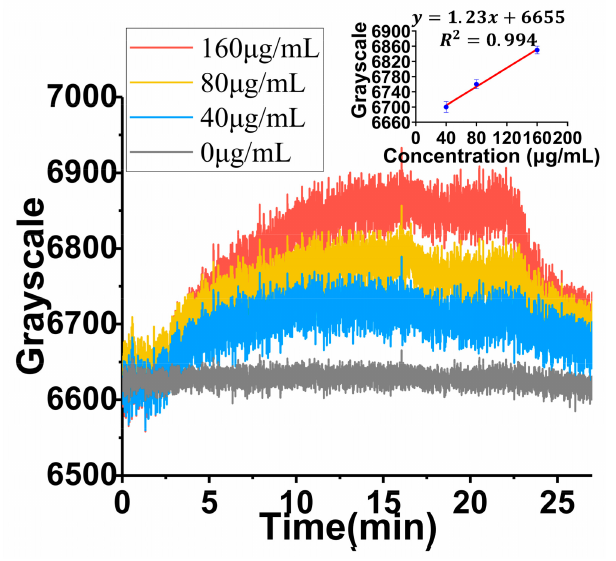
Figure 6. Detection of different concentrations of exosomes by TIRIE based on anti-CD9. The inset is the calibration curves of exosomes in three concentrations (40 µ g/mL, 80 µ g/mL, and 160 µ